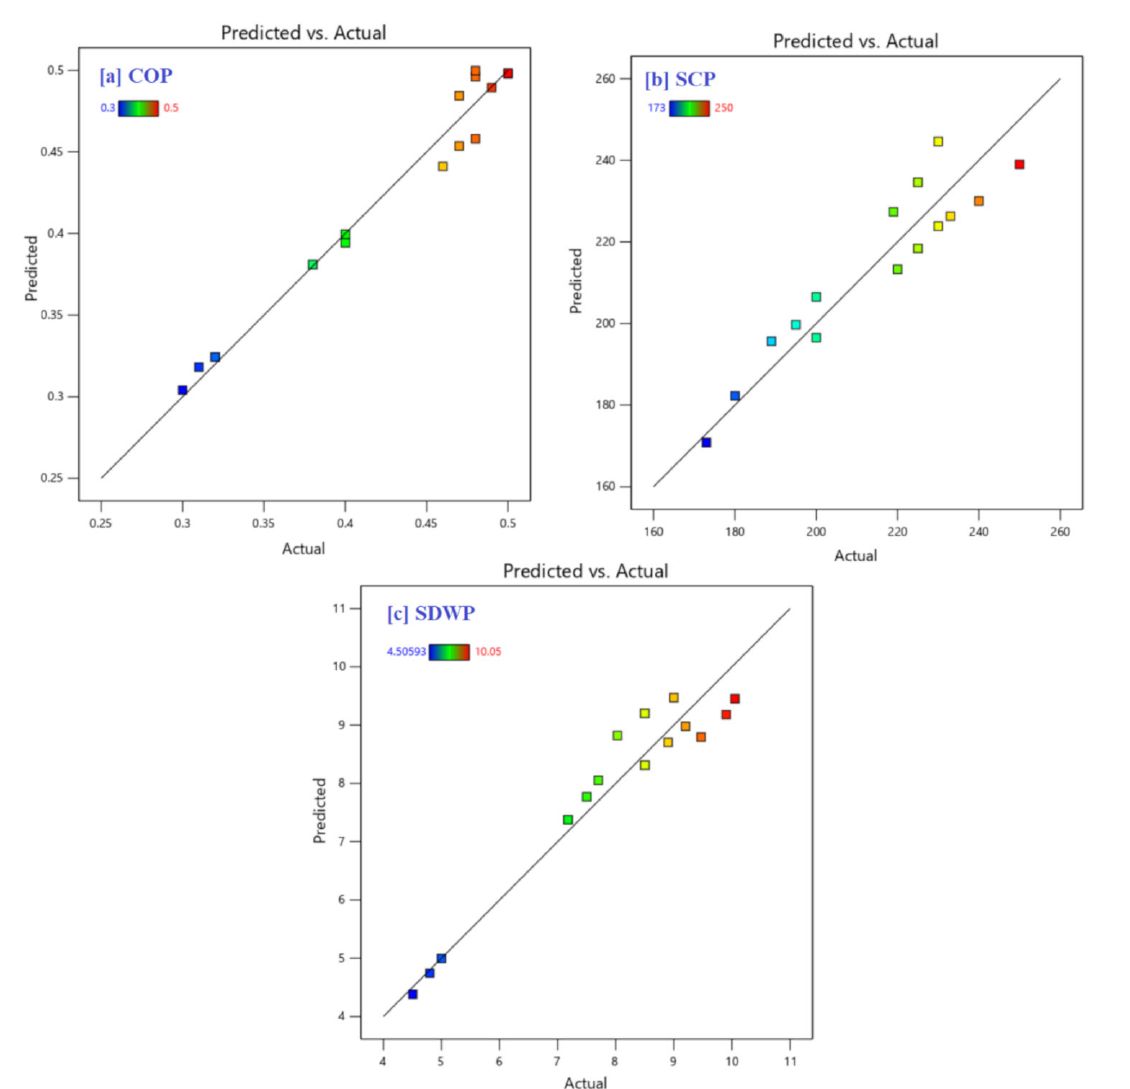
Figure 3. Comparison of the predicted values of output response ( a ) COP; ( b ) SCP, and ( c )